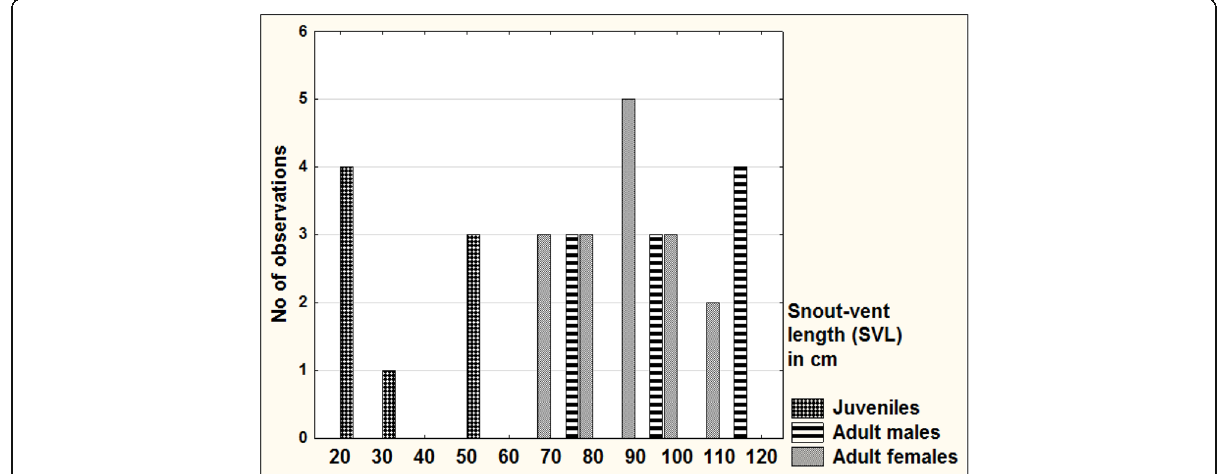
Fig. 4 Distribution of SVL among 34 blunt-nosed vipers from